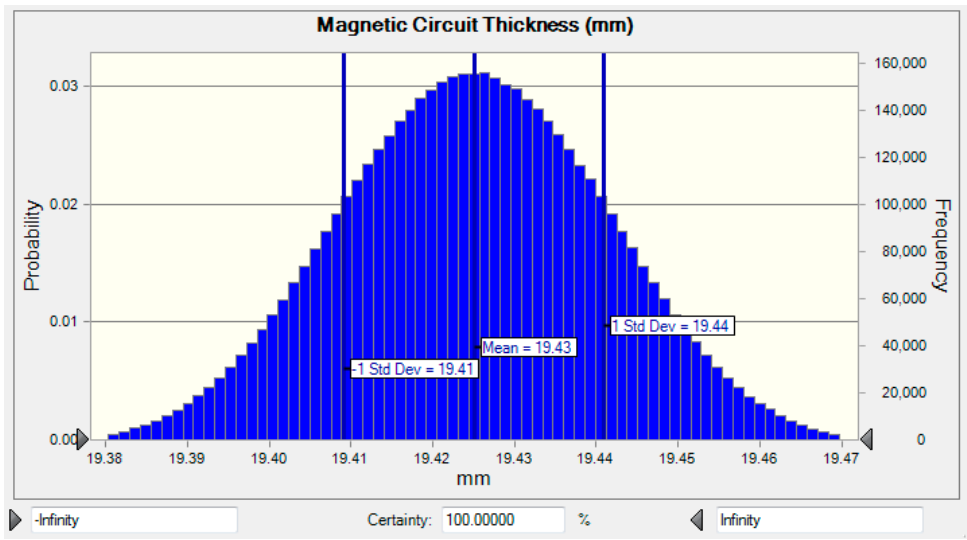
Figure 18. The performance distribution of thickness minimization by design tolerance.